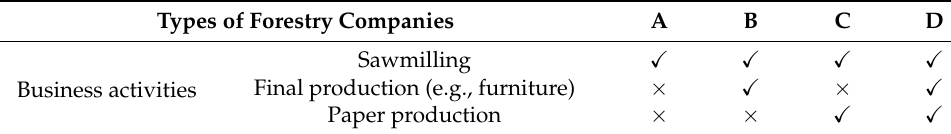
Table 1. Subgroups of forestry companies in terms of business